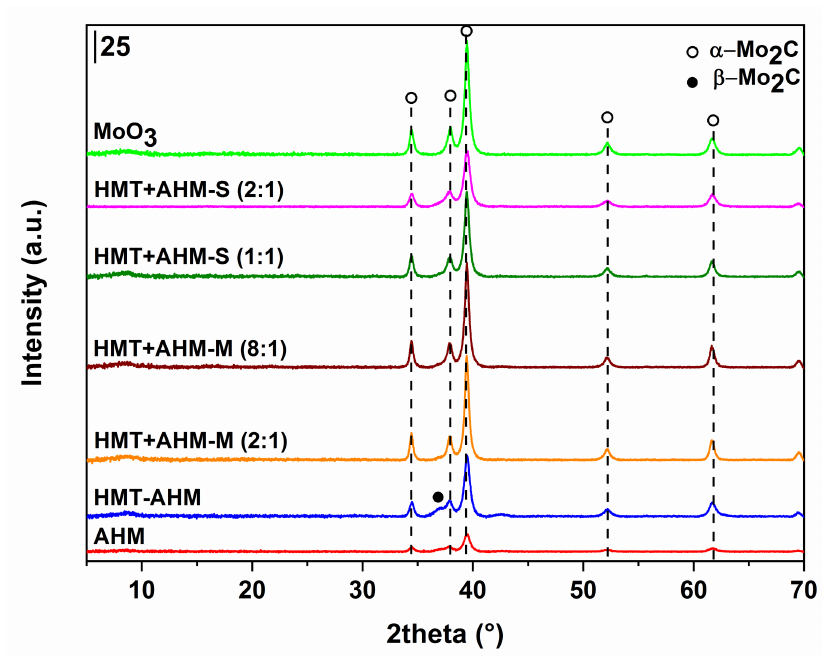
Figure 7. X-ray diffraction patterns of the molybdenum carbides prepared from different precursors at 700 ◦ C.